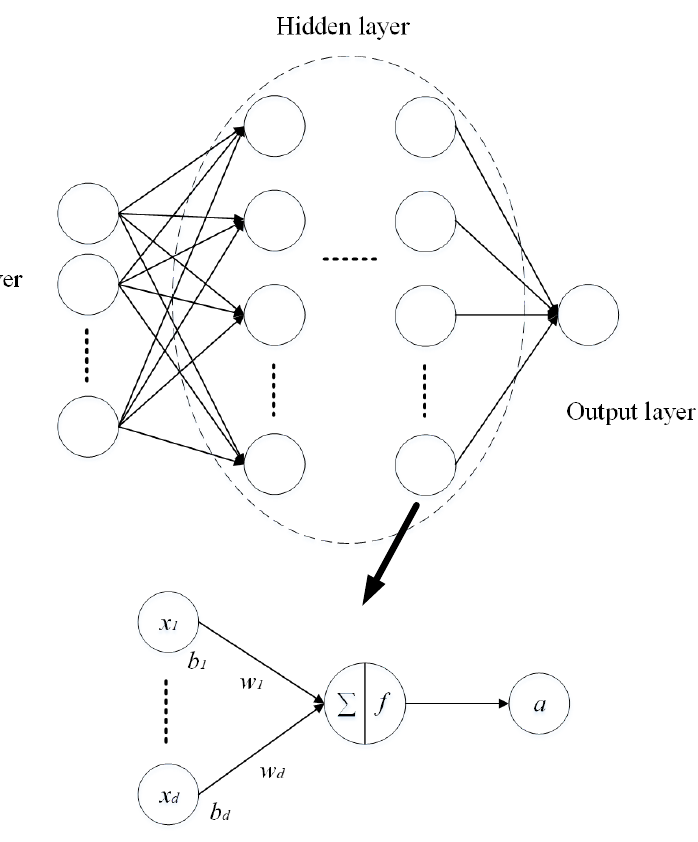
Figure 6. Schematic description of the FFNN.